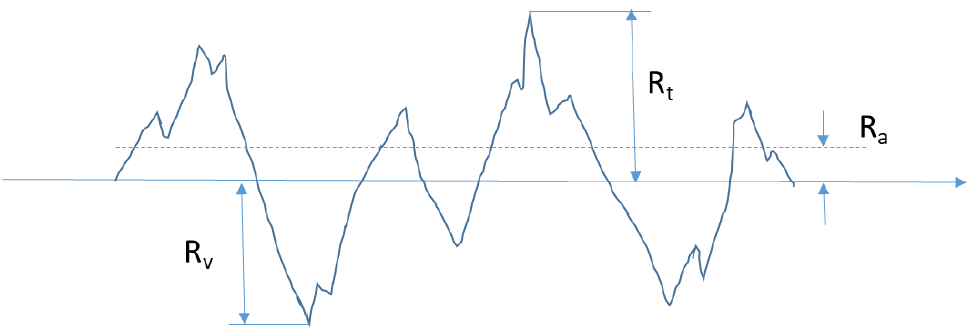
Figure 2. A schematic profile of surface roughness and its parameters, where R a is the arithmetic average of the roughness measurement, R t is the maximum peak vales and R v is the maximum valley value.